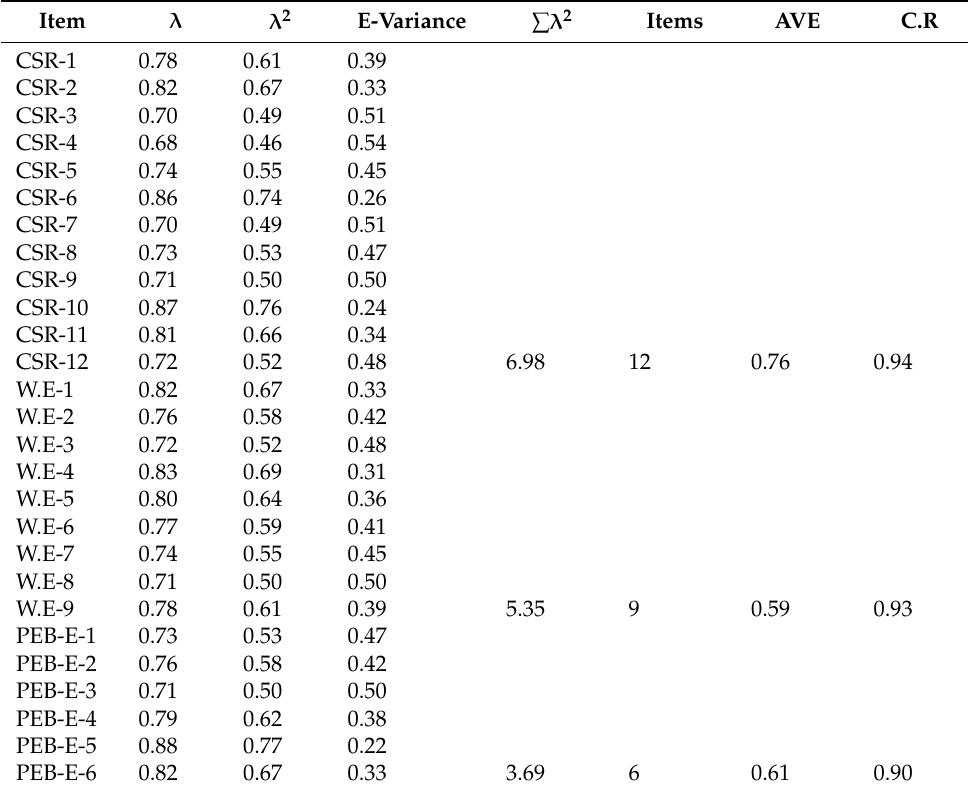
Table 3. Item loadings, convergent validity and reliability